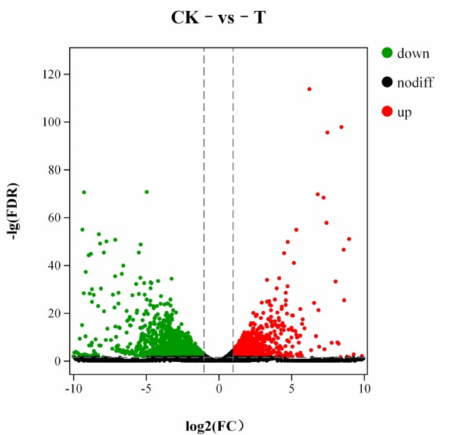
Figure 8. The volcano plot of differentially expressed